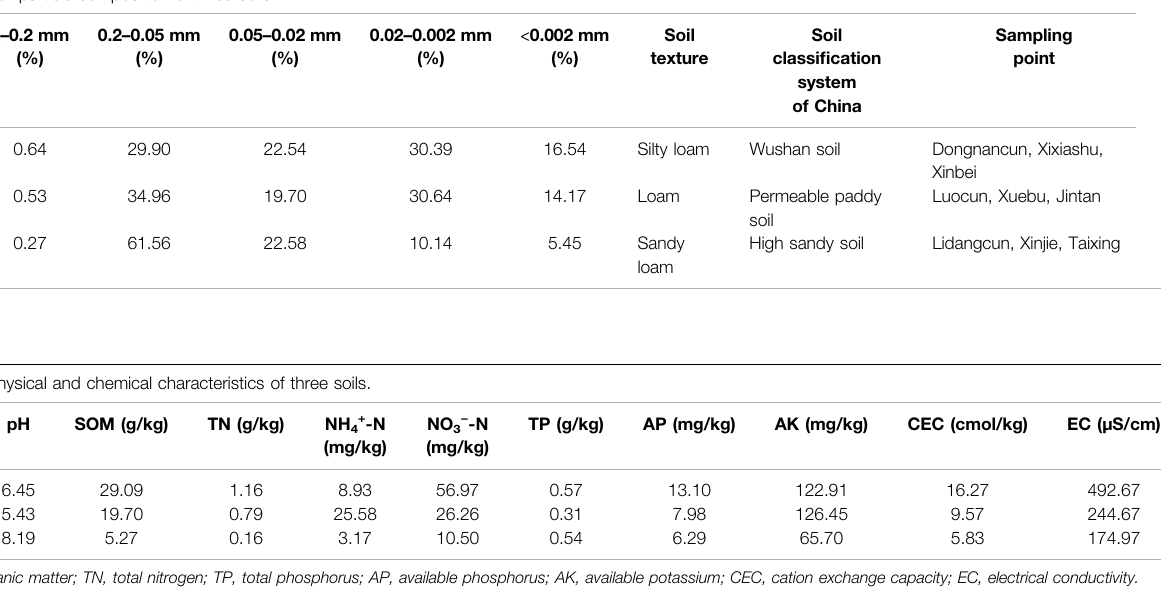
TABLE 2 | Soil particle composition of three soils. Soil 2 – 0.2 mm number (%)